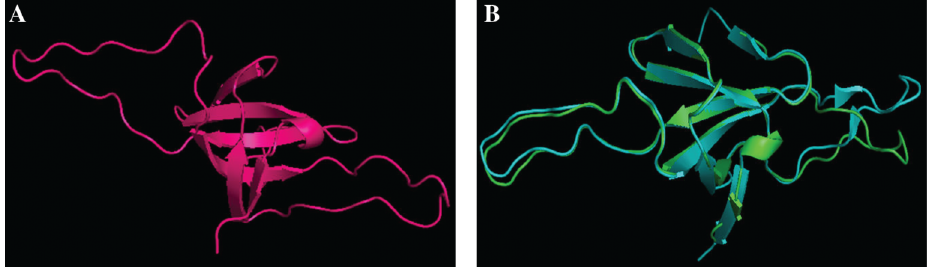
Figure 5: Predicted secondary structure of our protein of interest. (A) Representing the modeled structure of the query protein P9303_0.5031. (B) Show the super imposed structures of the modeled P9303_05031 and its template. Our modelled template is exactly super imposed on the chain A of